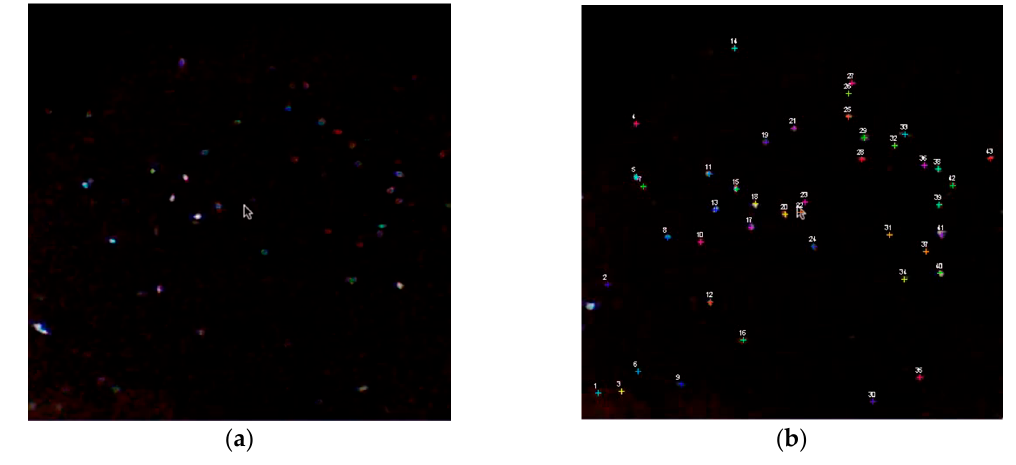
Figure 7. ( a ) Swimming protozoa: Paramecium organisms swimming in water were captured with iPhone 4S equipped with 4× objective; 100-mL sample in glass jar. Dark field illumination using flashlight. The dark field imaging facilitates the segmentation of object candidates. ( b ) Individual trajectories of Paramecium have a waveform apparently due to the spiral/helical motion of the organism. The waveforms seen apparently represent a helical path and the rotational speed is deductible from the time interval between two maximal readings (see Discussion). Computer vision using analysis of data as described by Kaakinen et al. [40].